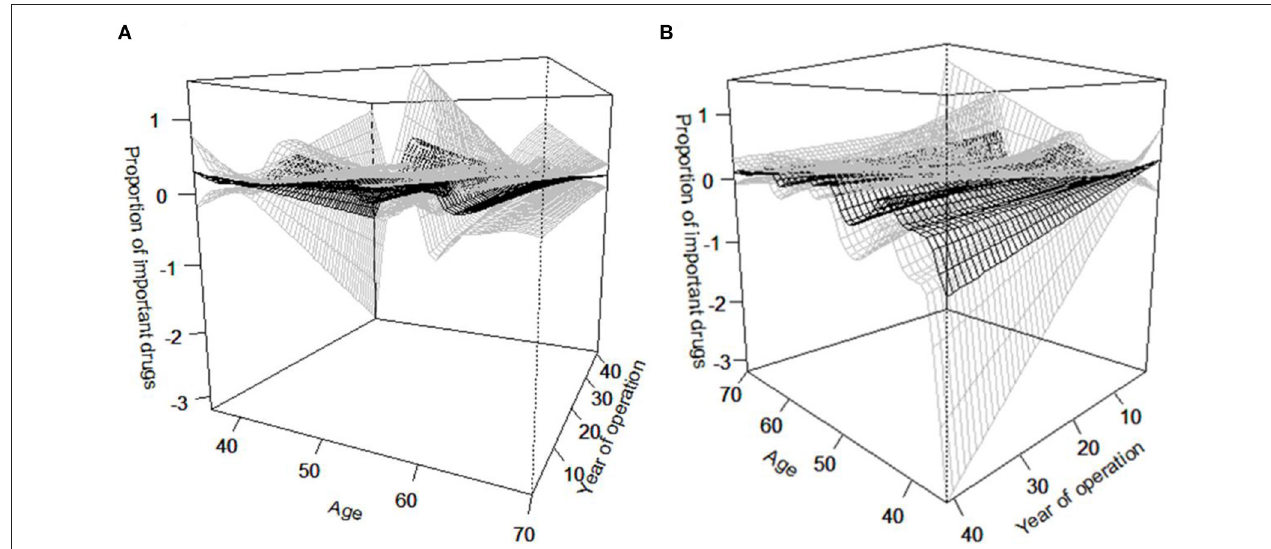
FIGURE 6 | 3D depiction of relationships between the proportion of important drugs among all antimicrobial drugs used, age of the clinic director, and years in operation shown from different angles. The relationships are shown from different angles to understand the factors associated with the proportion of important drugs in terms of (A) age of director, and (B) years of operation associated with the age of